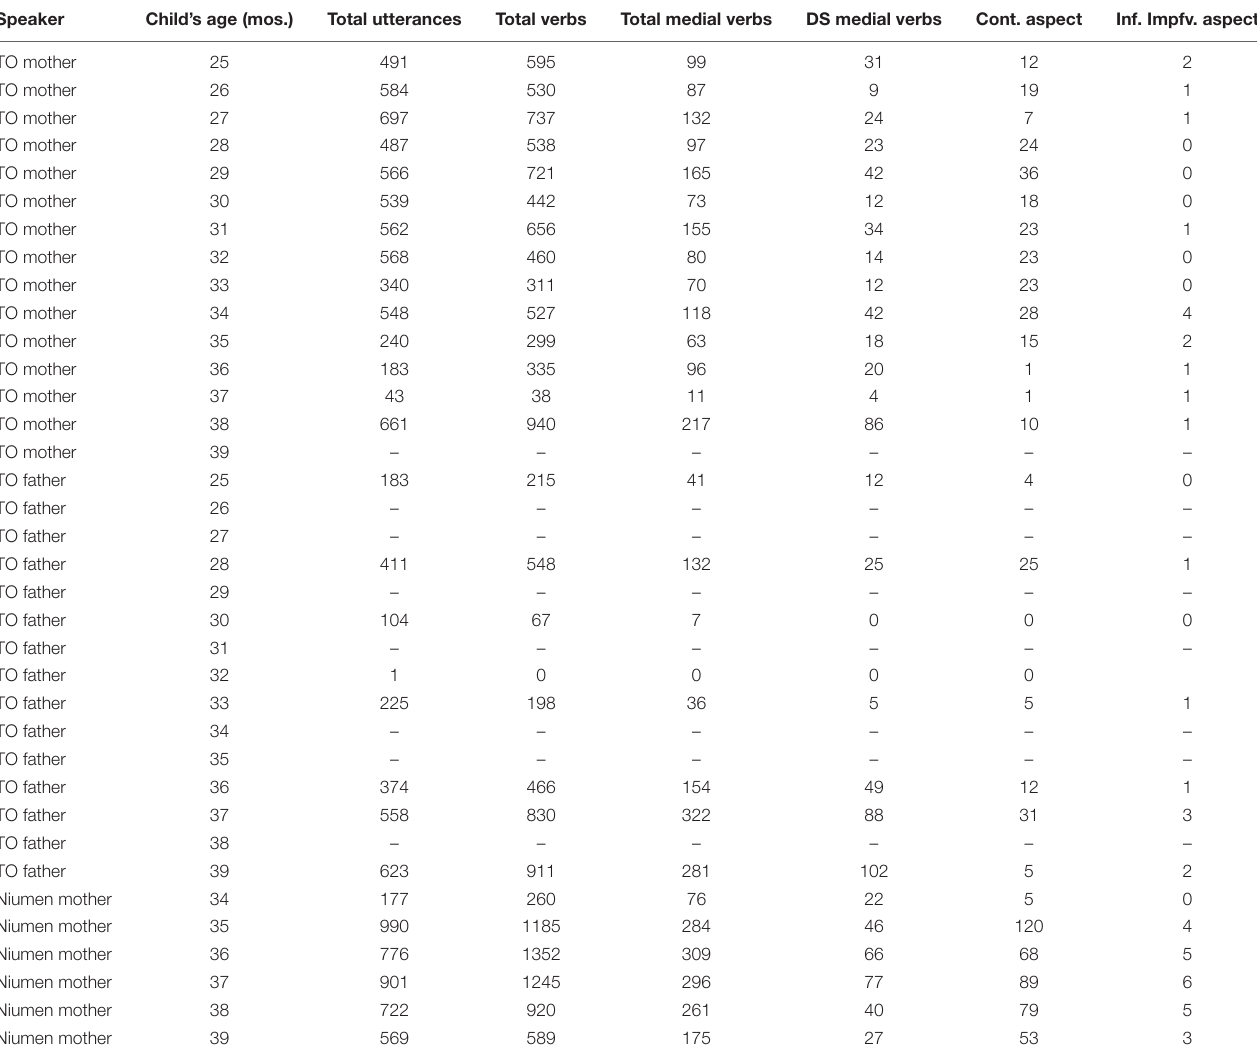
TABLE 2 | Counts of clause chain-related verb forms produced by